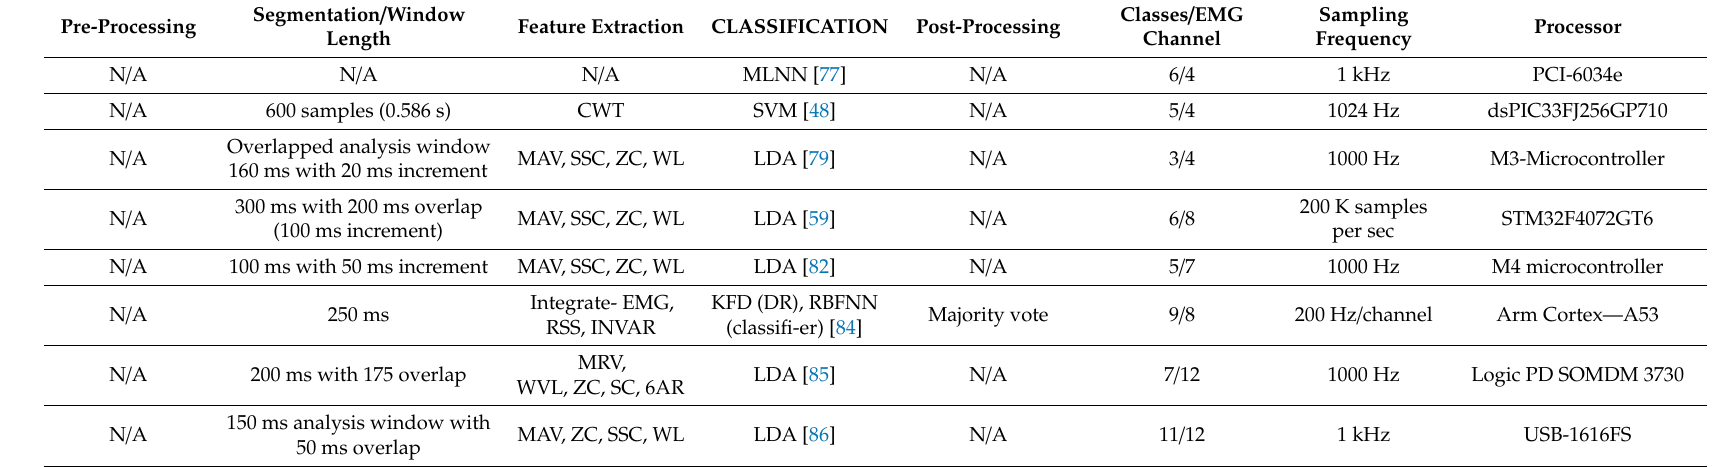
Table 2. Summary of the real-time controller in an embedded